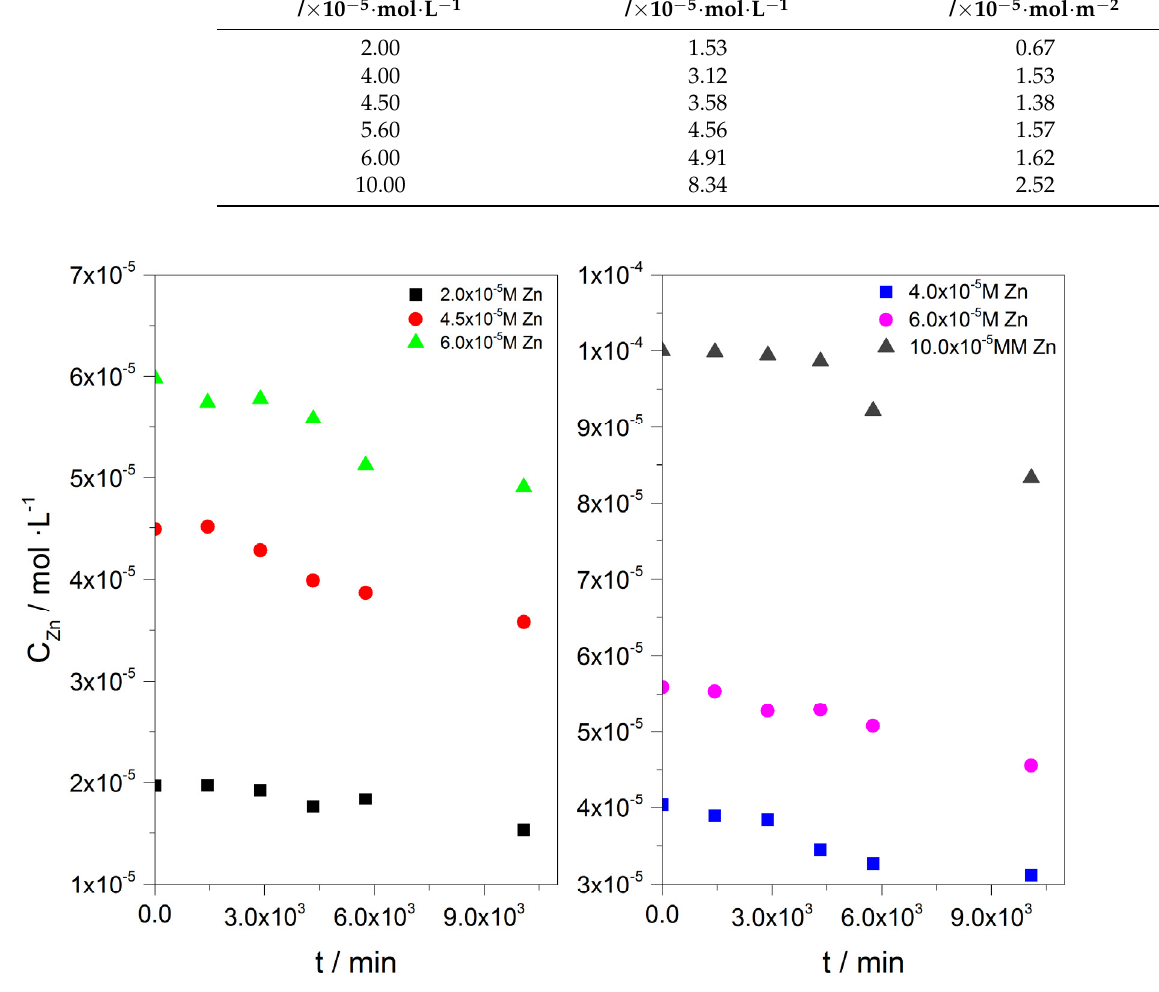
Figure 19. Zinc (II) concentration as a function of time during the uptake of zinc on calcite crystals in its saturated solutions, in the presence of 5 ml of A. obliquus culture; 25 °C, pH 8.50, 0.15 M of NaCl. The concentration of zinc tended to decrease over the 7 days equilibration